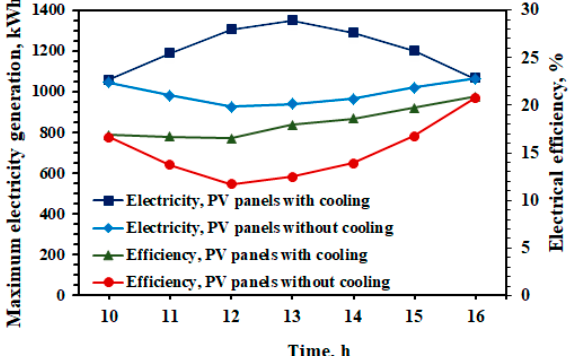
Figure 5. Variation of electricity generation and electrical efficiency from PV panels with and without the thermal recovery system. Figure 6 shows the in fl uences of preheating units on power consumption rates in the RO unit with an energy recovery device. As shown in Figure 6 for brackish water treat- ment, the SPC for the RO desalination unit with an energy recovery device reached 0.52 kWh/m 3 for the cases without utilizing preheating units (geothermal energy and thermal recovery system of PV panels), while for utilizing the thermal recovery system of PV pan- els and geothermal energy as preheating units, the SPC was reduced to 0.308 kWh/m 3 . Additionally, for seawater treatment, the SPC for the RO desalination unit with an energy recovery device reached 2.75 kWh/m 3 for the cases without utilizing the preheating units, while for utilizing the thermal recovery system of PV panels and geothermal energy as preheating units, the SPC was reduced to 1.95 kWh/m 3 . The saving in the speci fi c power consumption for utilizing the thermal recovery system of PV panels and geothermal en- ergy as preheating units reached 29.1% and 40.75% for seawater and brackish water treat- ment, respectively.